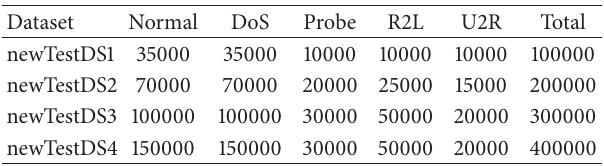
Table 4: Characteristics of new testing datasets used to evaluate the MAS-IDS processing